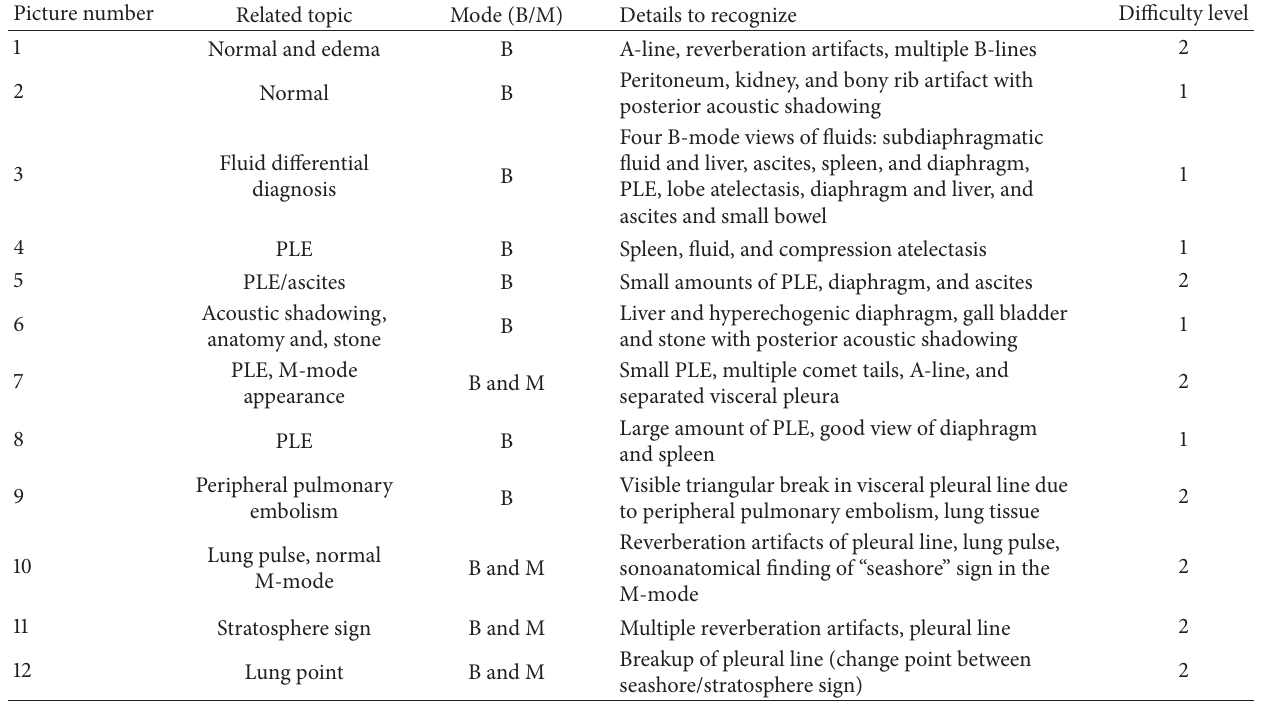
Table 3: Learning targets of the “virtual station” within the hands-on training